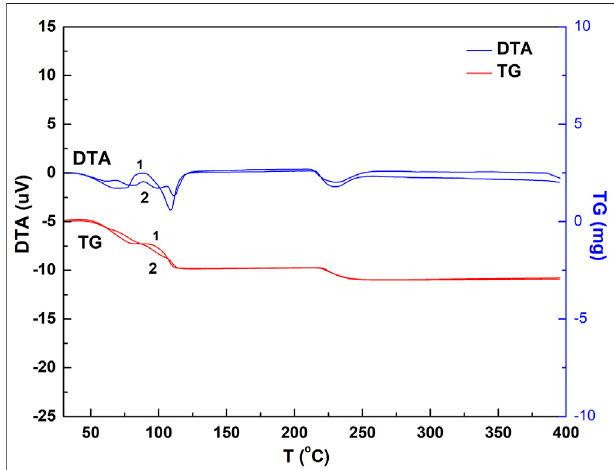
FIGURE 4 | DTA and TG spectrogram of the chalcanthite crystals with and without grinding. Note: upper curves 1 and 2 are DTA pro fi les of ground and non-ground chalcanthite, respectively, while lower curves 1 and 2 are TG pro fi les of the ground and non-ground chalcanthite crystals,